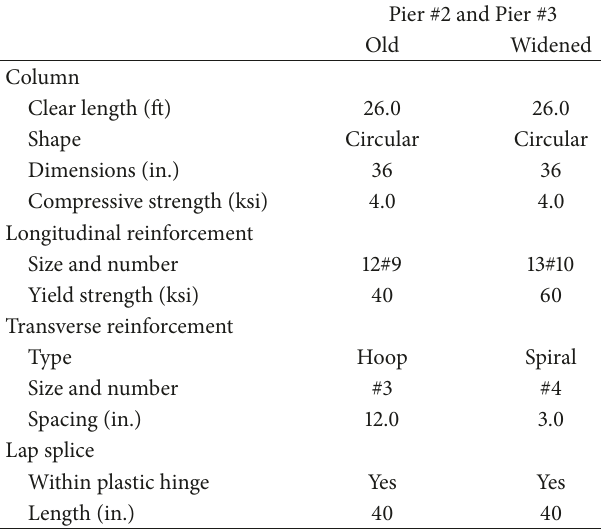
Table 5: Bridge #4-W columns’ geometric properties and reinforce- ment details.